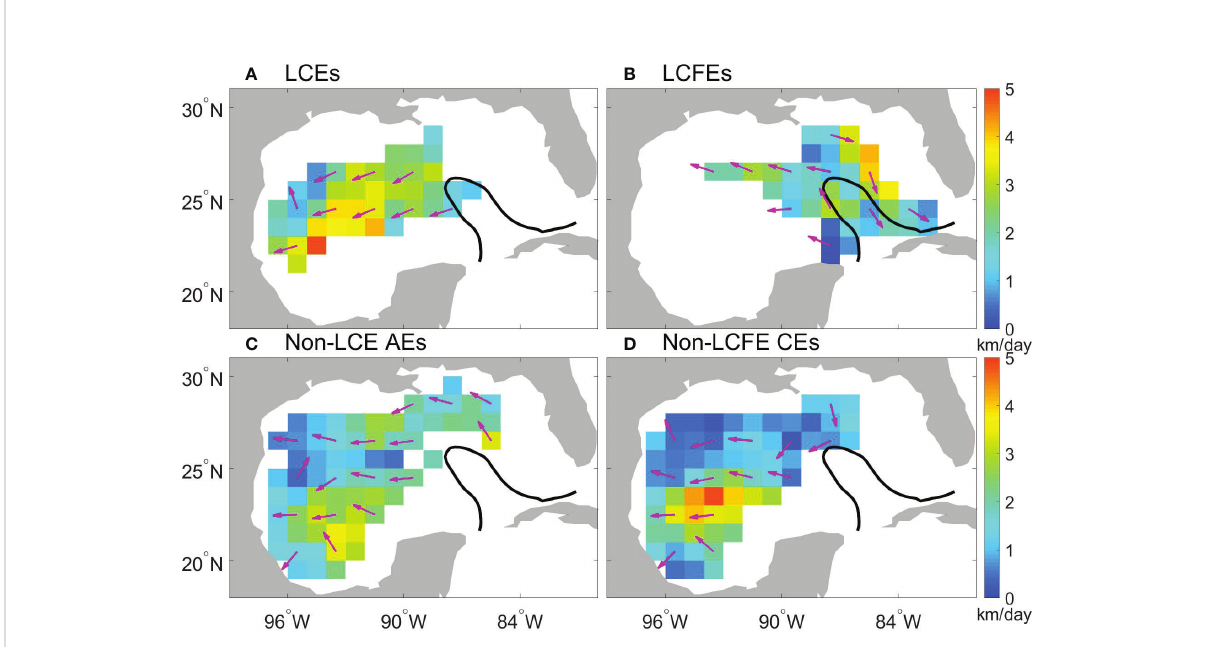
FIGURE 5 Mean eddy propagation speeds (color shading) and directions (magenta arrows) for (A) LCEs, (B) LCFEs, (C) non-LCE AEs, and (D) non-LCFE CEs. The thick black line represents the 25-cm contour of temporal mean SSH anomalies from 1993 to